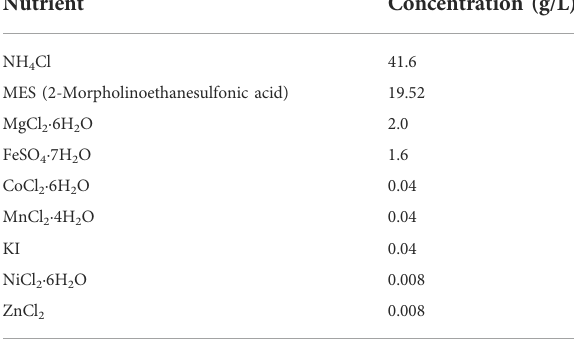
TABLE 1 Micronutrient supplementation composition used for BMP assays.